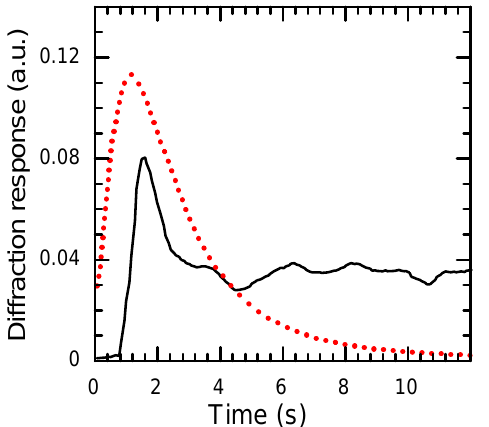
Figure 15. Kinetics of the hologram recording (solid line) and decay (dotted line) in :Ga,Y ( N = 1.1 × 10 18 cm − 3 ) crystal at room temperature. Recording at λ = 532 nm, CdF 2 Ga readout at λ = 632.8 nm. The maximal diffraction response at both switching and switching-off the recording radiation correspond to the phase incursion of λ /4. The one-second delay at switching the recording radiation is due to the response time of the gate cutting off the radiation.